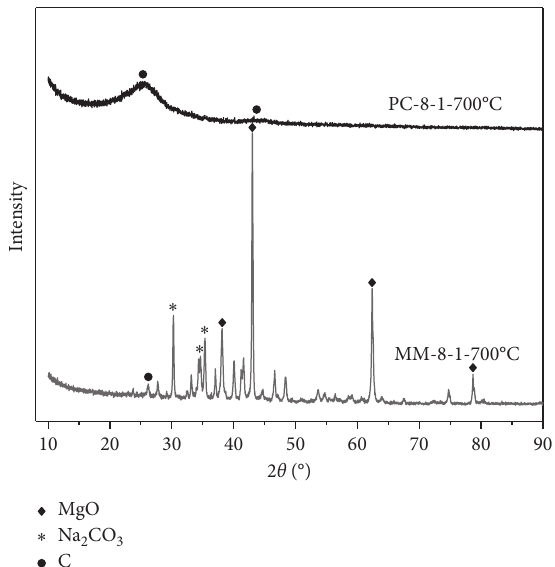
Figure 6: XRD patterns of MM-8-1-700 and